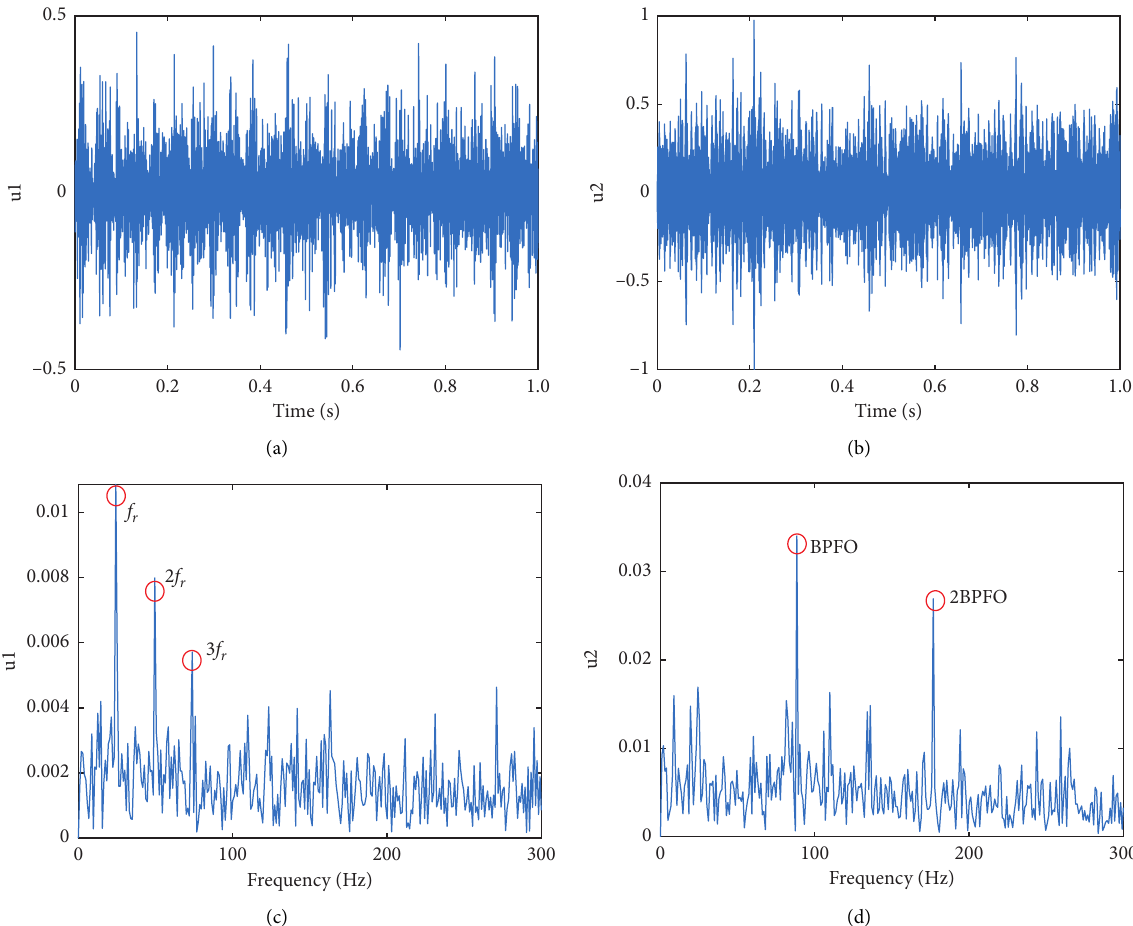
Figure 20: Experimental signals of case 1: signal processing results based on IPAVMD: (a, b) time-domain waveform of each mode and (c, d) the corresponding squared envelope